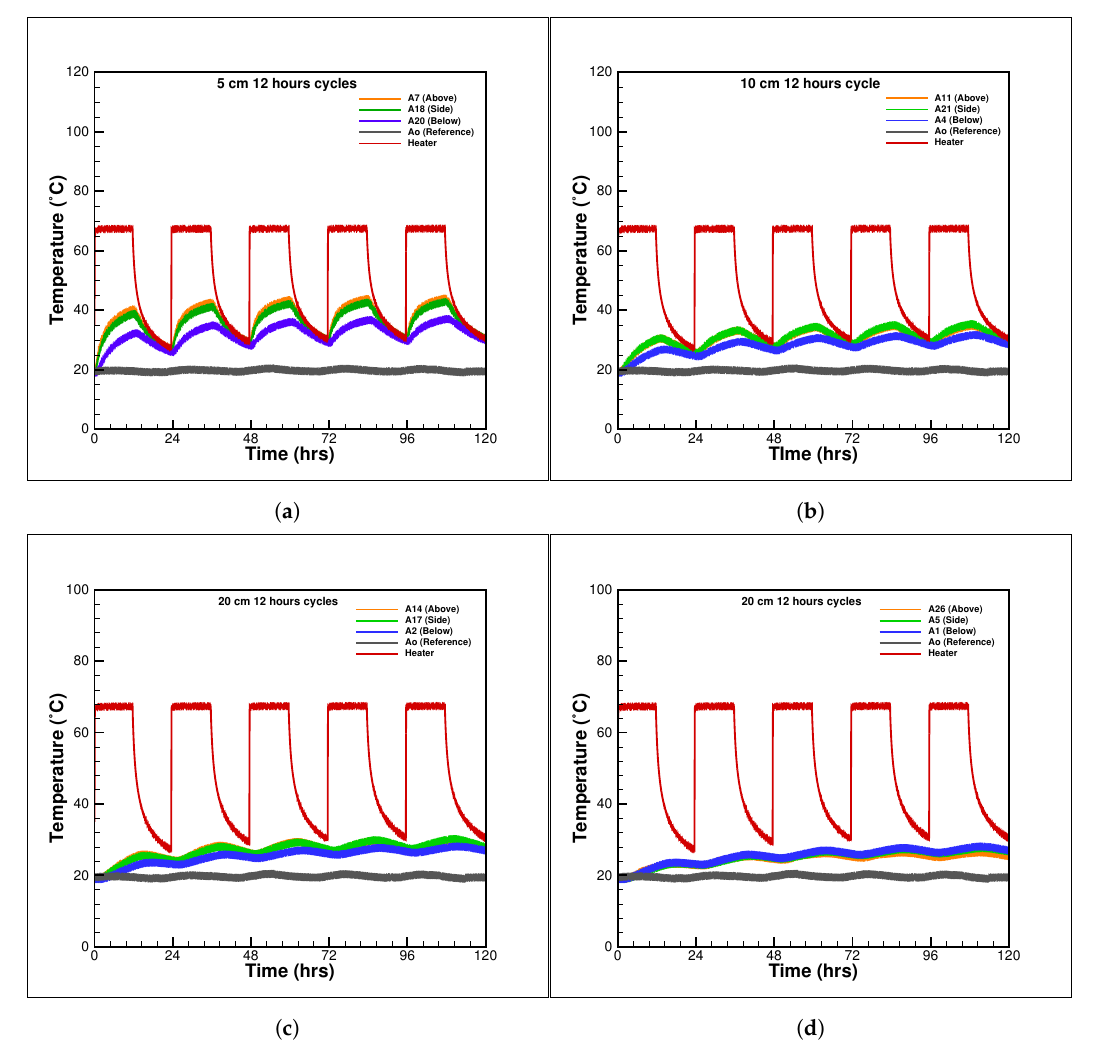
Figure 8. Temperature plot with 5 days cyclic 12 h heating and 12 h cooling of 70 °C at ( a ) 5 cm; ( b ) 10 cm; ( c ) 15 cm; ( d ) 20 cm from the heater surface.